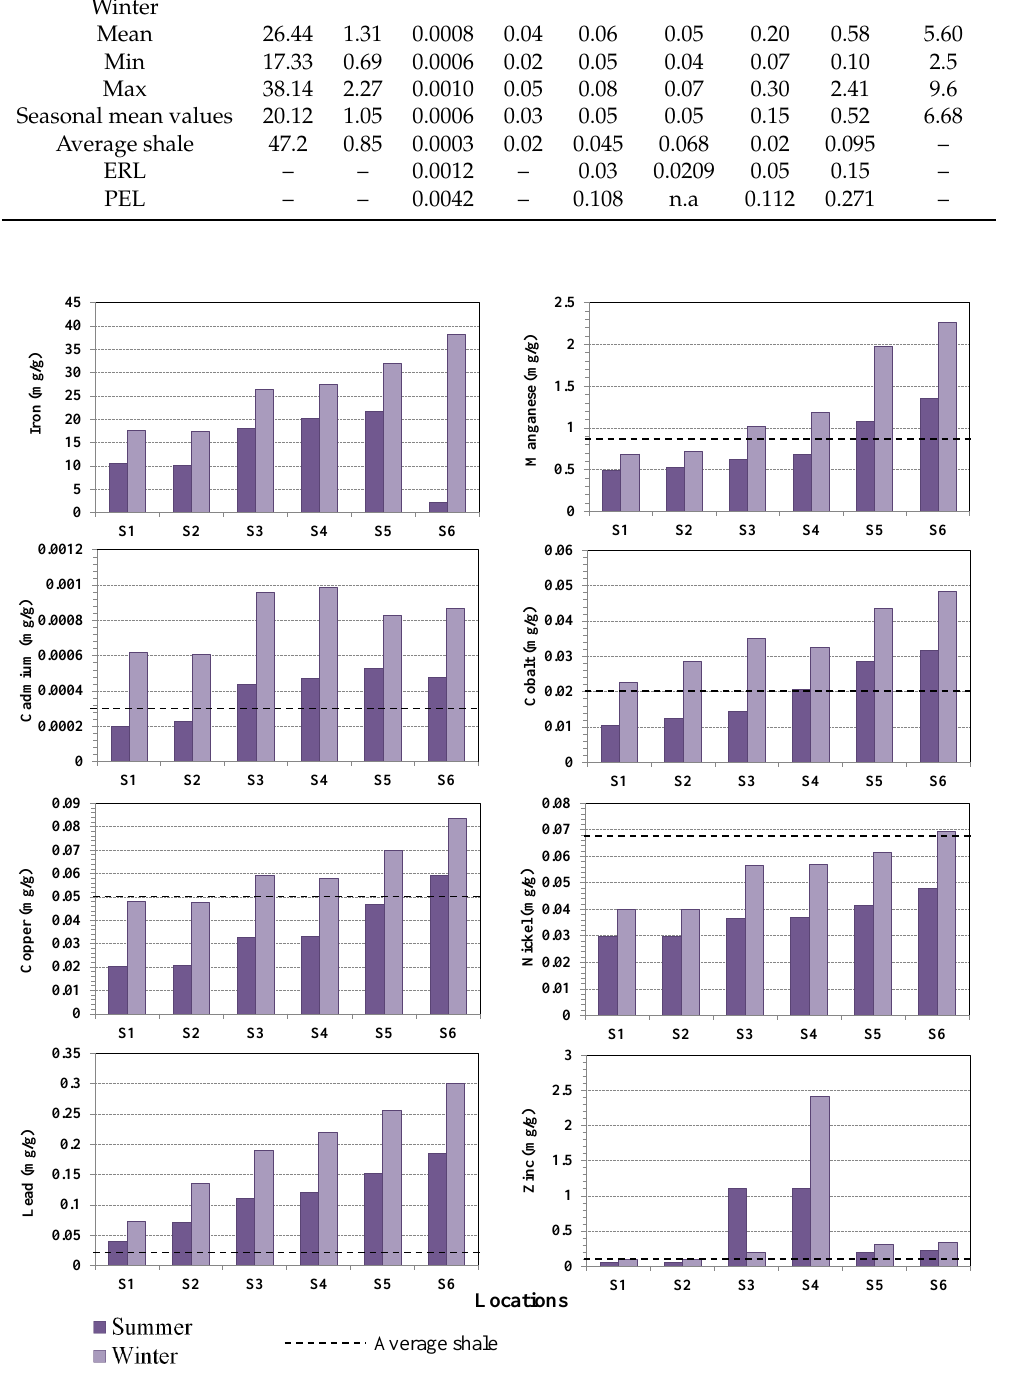
Figure 2. Total toxic trace metal concentrations in Damietta branch sediments during summer and winter